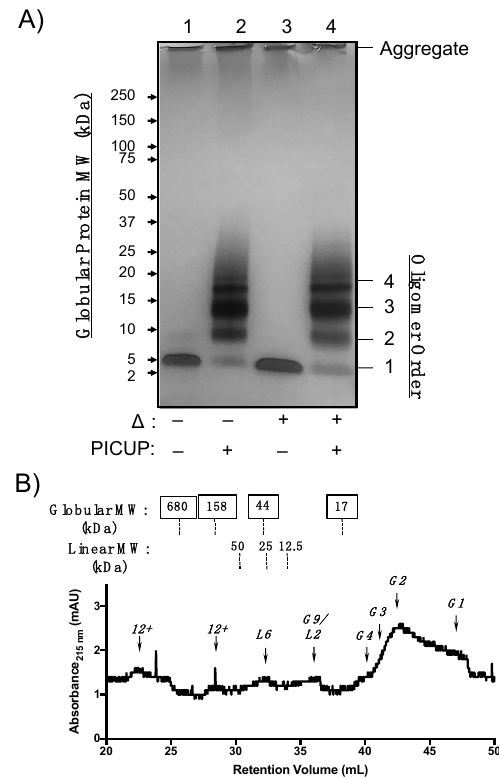
Figure 2. Structural characterization of WT A β 40 oligomer quaternary structure. ( A ) Silver-stained SDS-PAGE gel of WT A β 40 oligomers after 24 h incubation at 4 °C in phosphate-buffered saline (PBS). Proteins were separated on Criterion ™ XT 4 − 12% bis-tris gradient gels. Samples in lanes 1 and 3 were not covalently cross-linked. Samples in lanes 2 and 4 were subjected to photo-induced cross-linking of unmodified proteins (PICUP). Lanes 3 and 4 were thermally denatured ( Δ ) for 5 min at 95 °C prior to SDS-PAGE separation. ( B ) SEC chromatogram of cross-linked WT A β 40 oligomers separated using three analytical gel filtration columns linked in tandem. Approximate molecular weights of globular (top row, boxed labels) and linear (bottom row) standards are listed above the chromatogram. The oligomer assembly state corresponding to each peak is listed above an arrow for globular (G1, G2, etc.) and linear (L1, L2, etc.) morphologies.